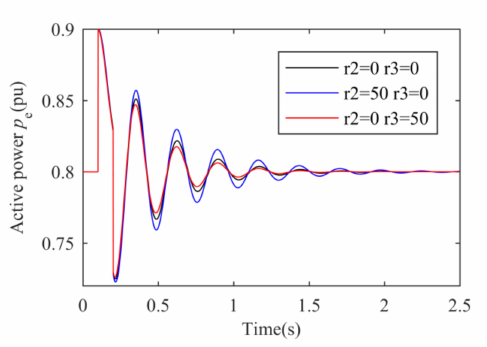
Figure 5. Effects of damping factor on the diesel generator set